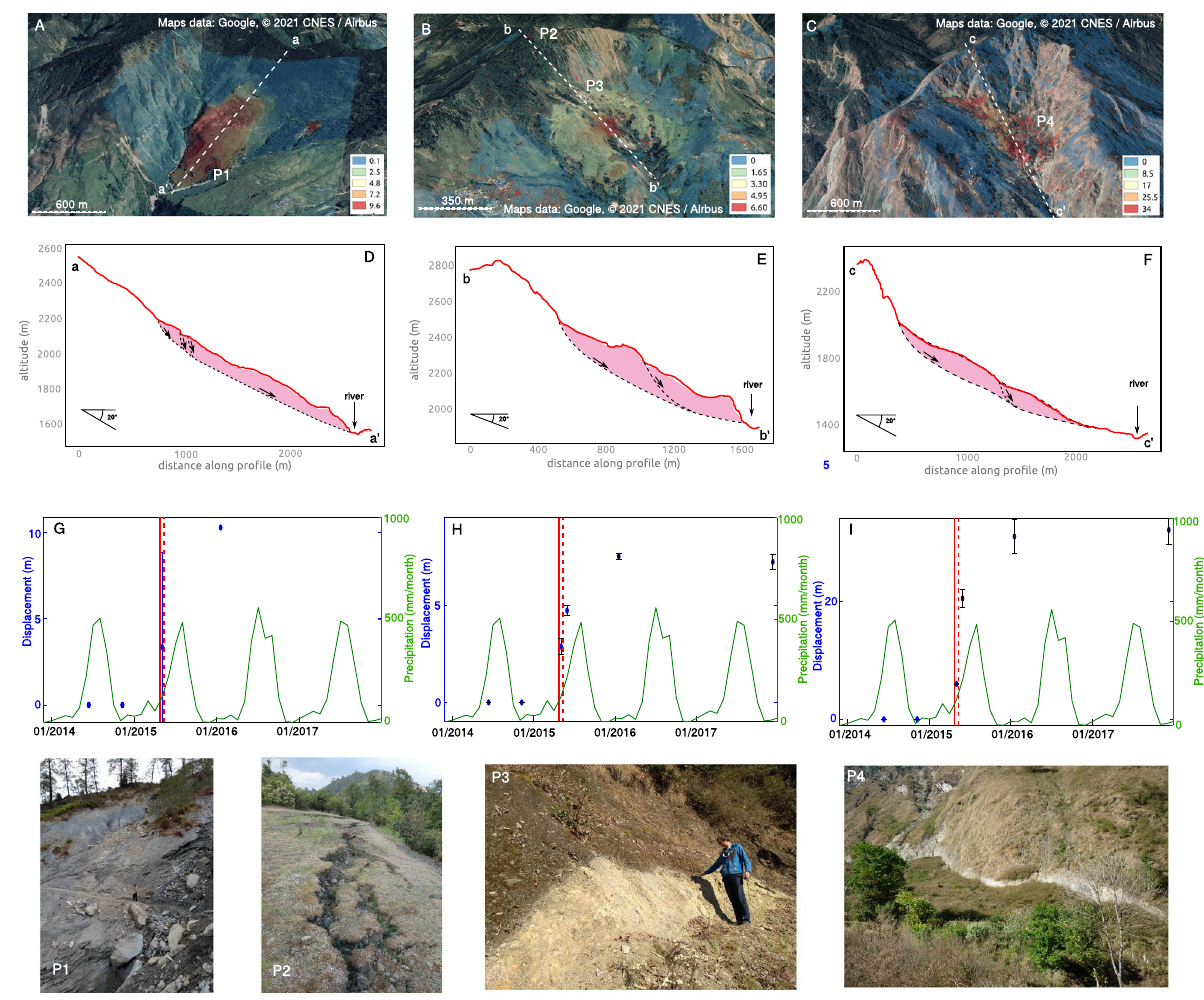
Figure 3. Pléiades displacement fields (see section Methods) overlayed over a Google-Earth view ( A – C ), interpretative cross-sections ( D – F ) , and time-series of the cumulative displacement obtained from Pléiades data ( G – I ) and monthly rainfall extracted from the GPCC-v2018 dataset 31 on 3 detected landslides: Tapgaon ( A , D , G ), Gumba ( B , E , H ), and Duguna Gadi ( C , F , I ). Pictures show some key general features observed on these 3 landslides: colluvial debris including very large blocks (20 × 20 × 20 m ) both on the surface and outcropped by the river erosion (P1), shallow fractures on the above ridges (P2), head- (P3) and lateral- (P4) scarps reaching up to 30 m. Google-Earth (https:// earth. google. com/) was used to create the subfigures ( A – C ). Inkscape (www. inksc ape. org) was used to create subfigures ( D – F ). Matlab (www. mathw orks. com) was used to create subfigures ( G – I